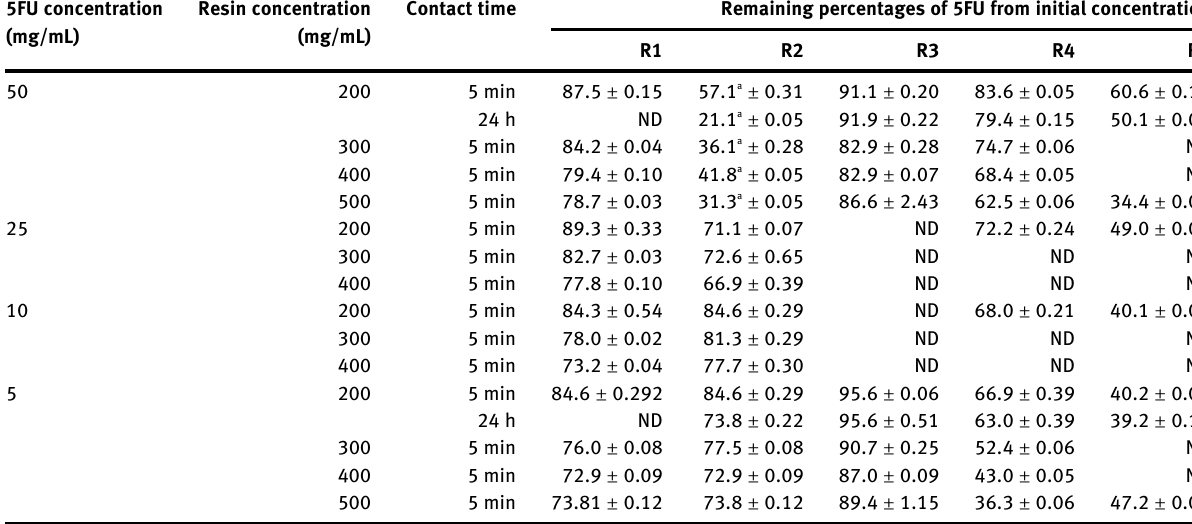
Table  : Evaluation of  FU complexation by